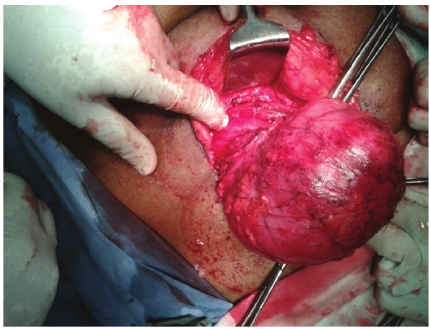
Figure 5: Intraoperative cyst with extension into abdominal wall muscle.